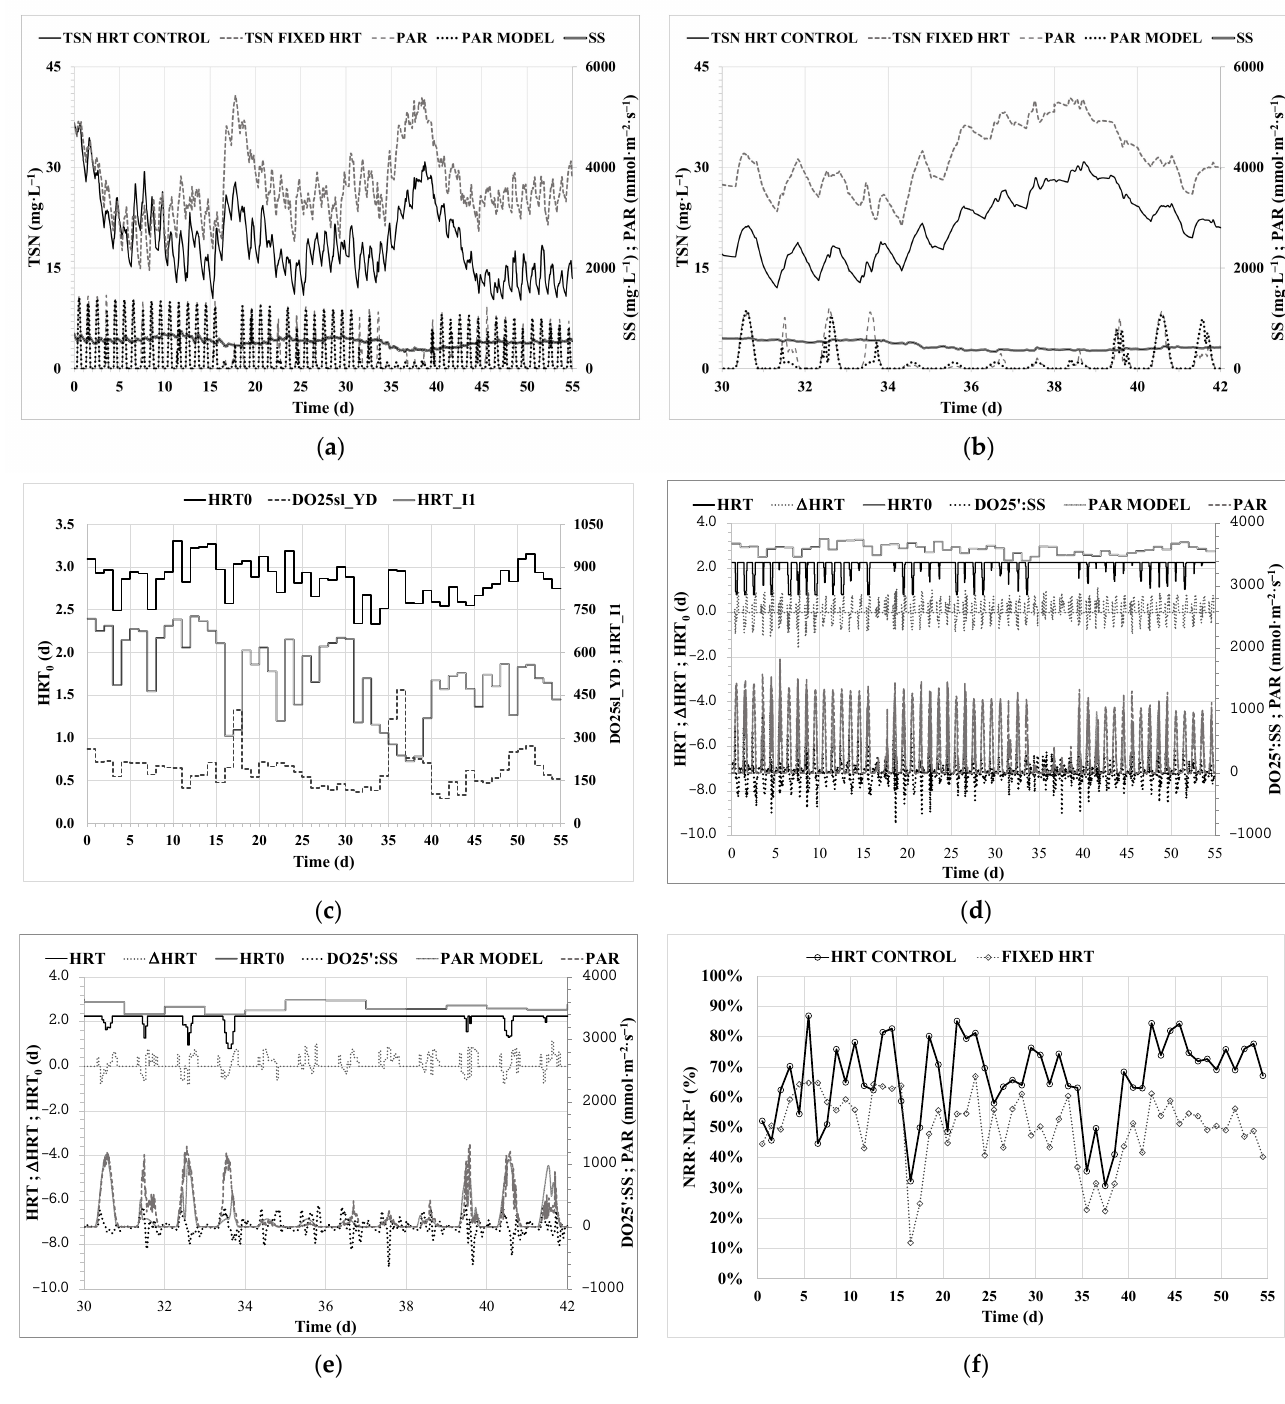
Figure 8. Continuous HRT controller action. ( a ) MPBR performance; ( b ) MPBR performance in days 30–42; ( c ) HRT0 controller action; ( d ) Hourly HRT controller action; ( e ) Hourly HRT controller action in days 30–42; ( f ) NRR·NRL − 1 (%) operating at fixed-HRT and HRT control.